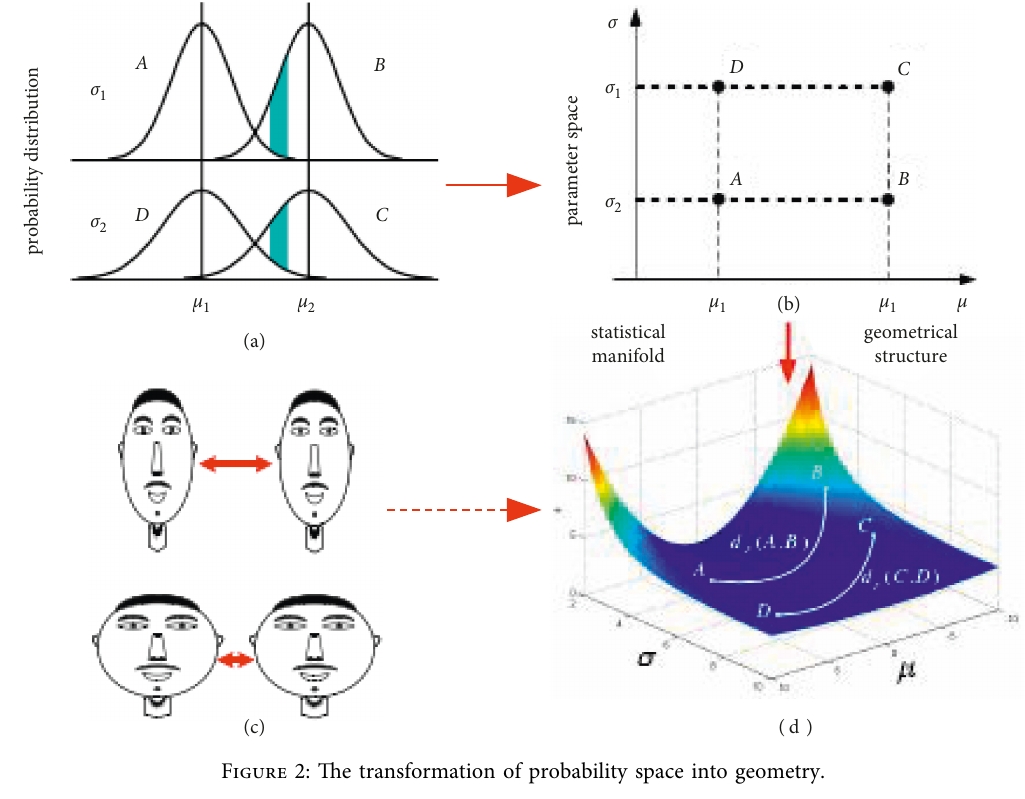
Figure 2: The transformation of probability space into geometry.